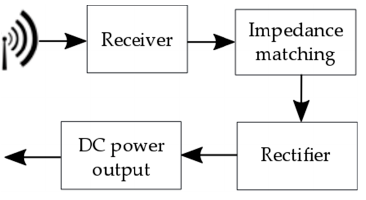
Figure 39. Scheme of an RF EH system.